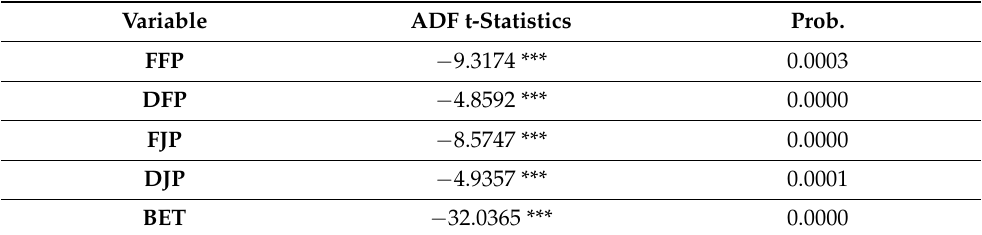
Table 6. Results of unit root tests.